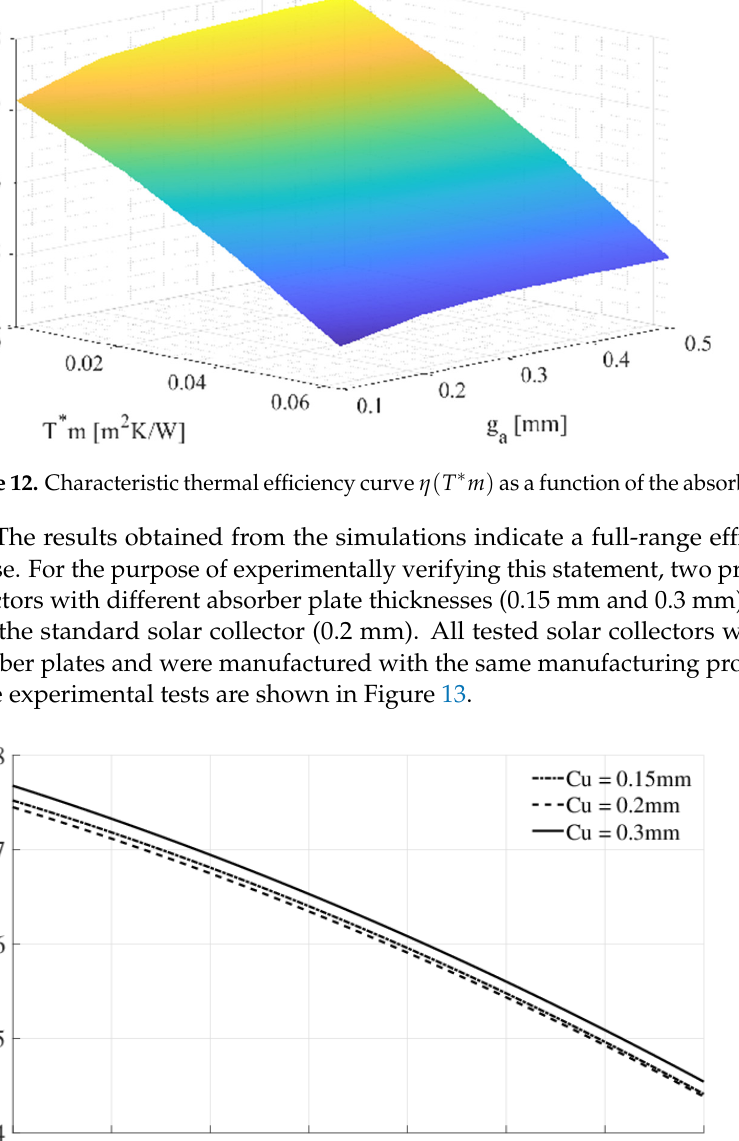
Figure 11. Comparison between the efficiency curves (cid:2015)((cid:1846) ∗ (cid:1865)) of a standard collector and a modified collector with an increased spacing between working pipes.